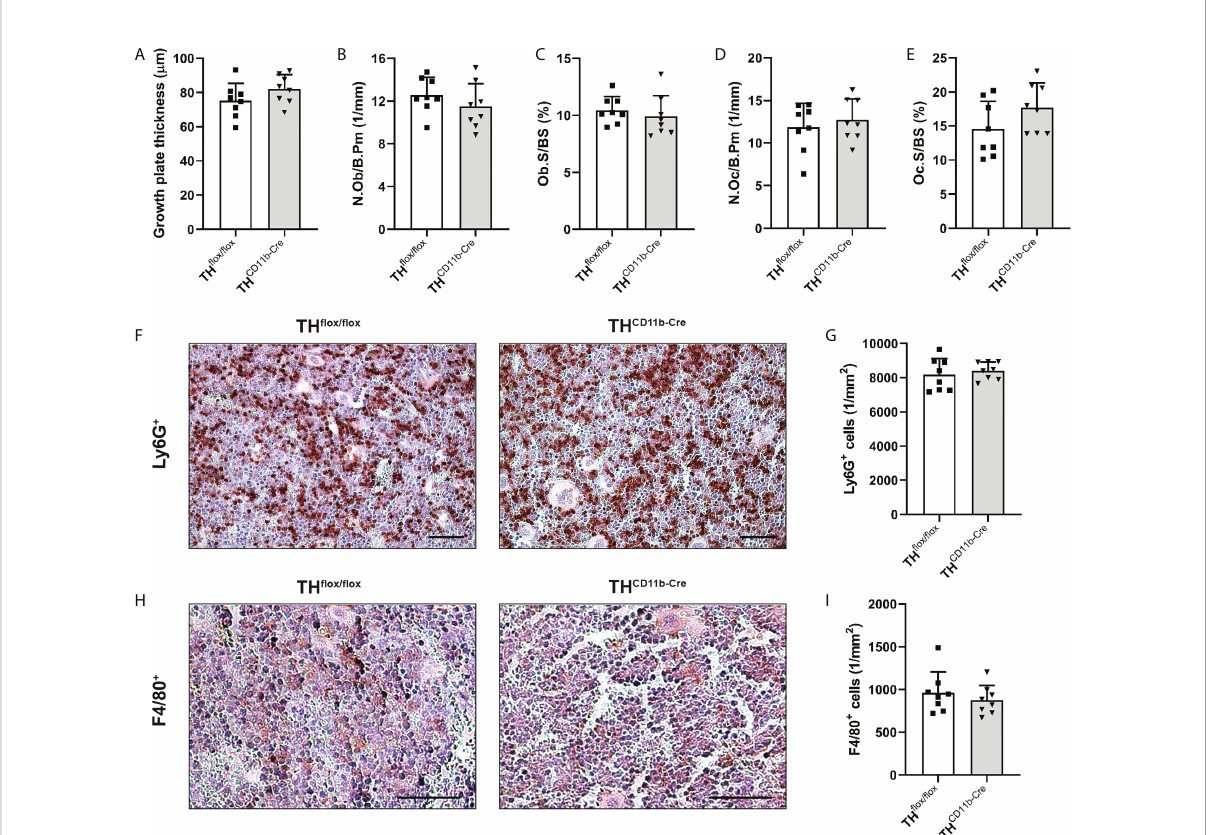
FIGURE 2 Histological and immunohistochemical analysis of femora of eight-week-old TH CD11b-Cre mice. (A) Growth plate thickness, (B) number of osteoblasts per bone perimeter (N.Ob/B.Pm), (C) osteoblast surface per bone surface (Ob.S/BS), (D) number of osteoclasts per bone perimeter (N.Oc/B.Pm), (E) osteoclast surface per bone surface (Oc.S/BS), immunohistochemical staining and quanti fi cation of (F, G) Ly6G + neutrophils and (H, I) F4/80 + macrophages in femora of eight-week-old TH fl ox/ fl ox and TH CD11b-Cre mice. Scale bars represent 50 µm. n =